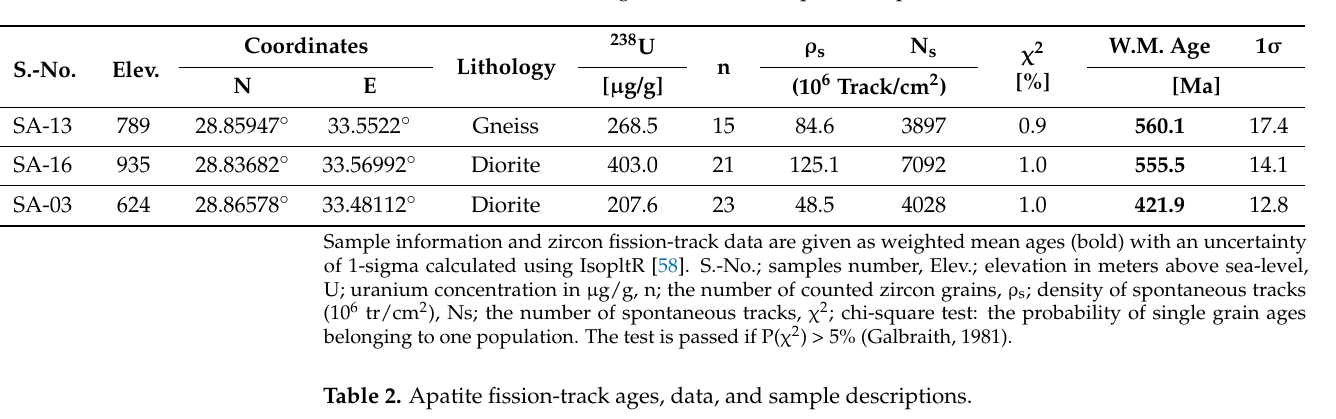
Table 1. Zircon fission-track ages, data, and sample descriptions.